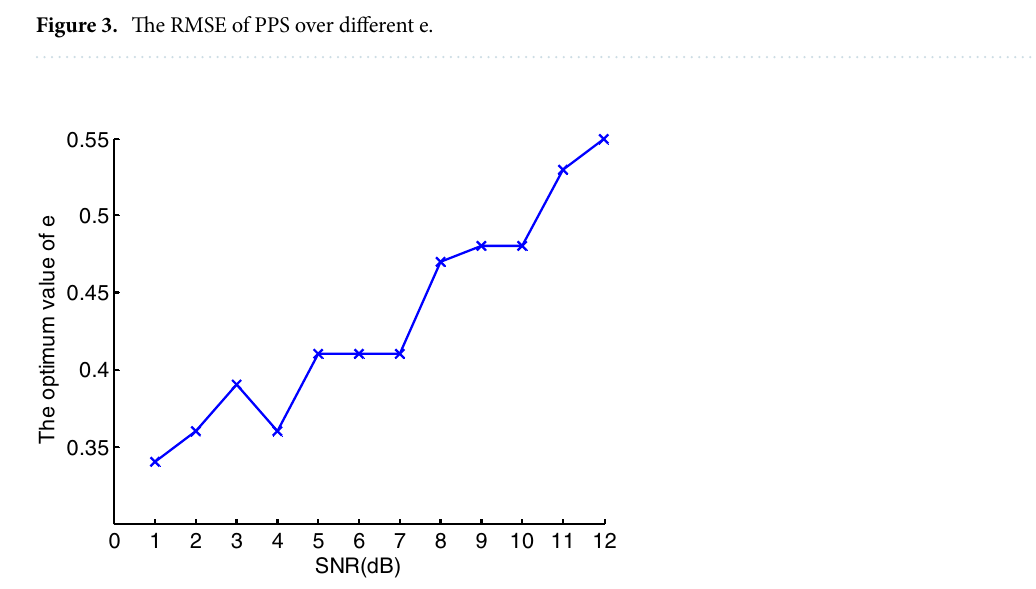
Figure 4. The optimum value of e over the SNR from 1 to 12